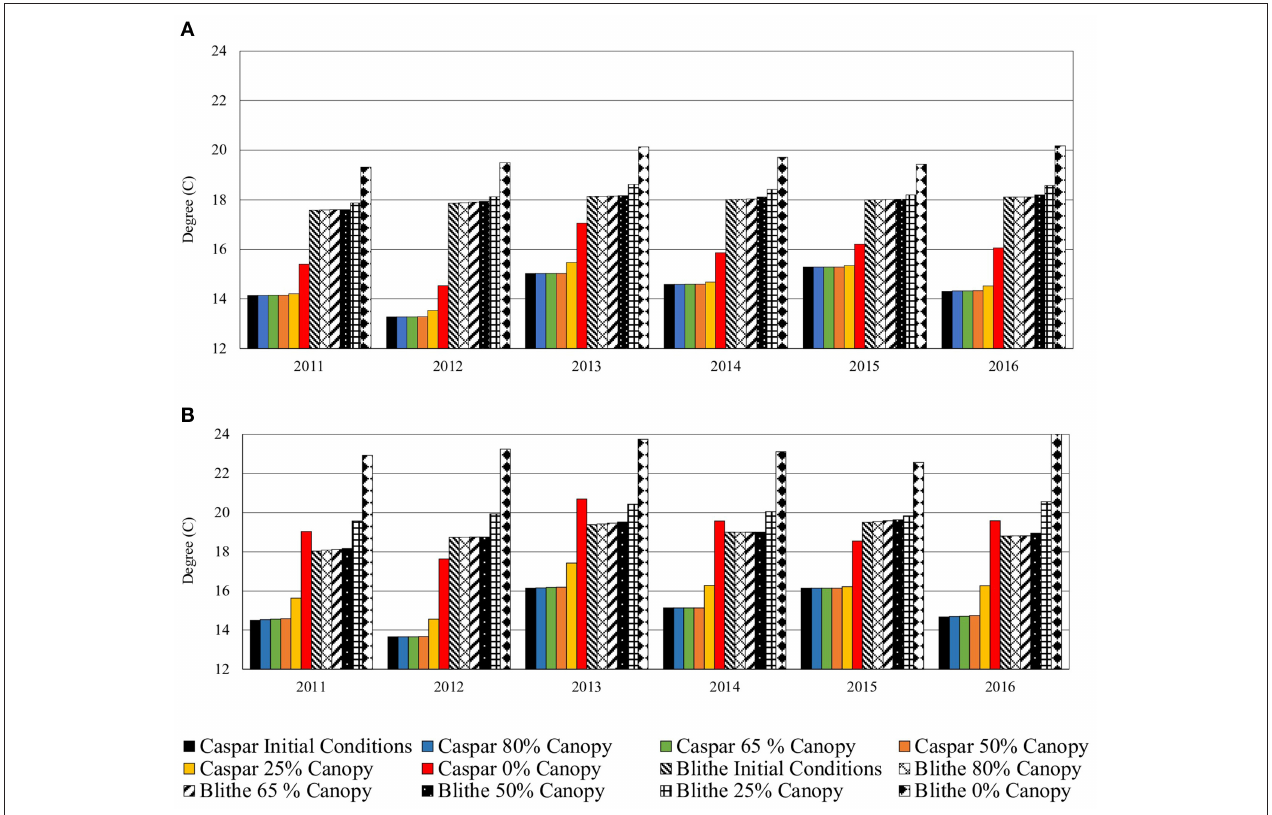
FIGURE 5 | Simulated (A) MWAT and (B) MWMT temperatures using the South Fork of Caspar Creek or Blythe, CA CIMIS air temperature and relative humidity values. Solid lines use Caspar collected values, while dashed lines use Blythe, CA collected values.